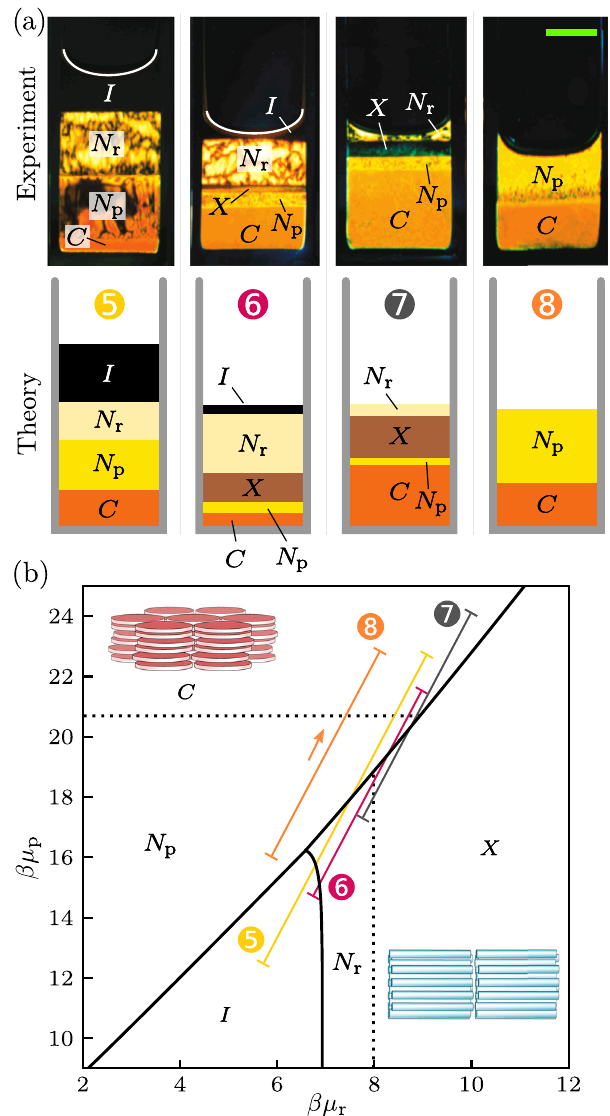
Fig. 5 Positionally ordered phases. a Experimental samples and corresponding theoretical predictions of sequences containing isotropic ( I ), nematic plate-rich ( N p ), and nematic rod-rich ( N r ) fl uid layers as well as layers with positional order: C (columnar plate-rich) and X (smectic rod- rich). The white line indicates the position of the meniscus. The photographs of the experimental samples (adapted with permission 23 , Copyright 2000 American Chemical Society) were taken from crossed polarizers. The scale bar (green) is 5 mm. b Bulk phase diagram in the plane of chemical potential of rods μ r and plates μ p for the region next to the triple point. The chemical potentials are scaled with the inverse temperature β = 1/( k T ). Solid lines are the binodals involving isotropic and nematic B phases obtained with density functional theory. Dotted lines are the inferred location of the N p − C (horizontal line) and N r − X binodals. Schematics of particle arrangement in the C and X phases are shown. The sedimentation paths correspond to the samples shown in (a). The orange arrow in sample 8 indicates the direction of the paths from top to